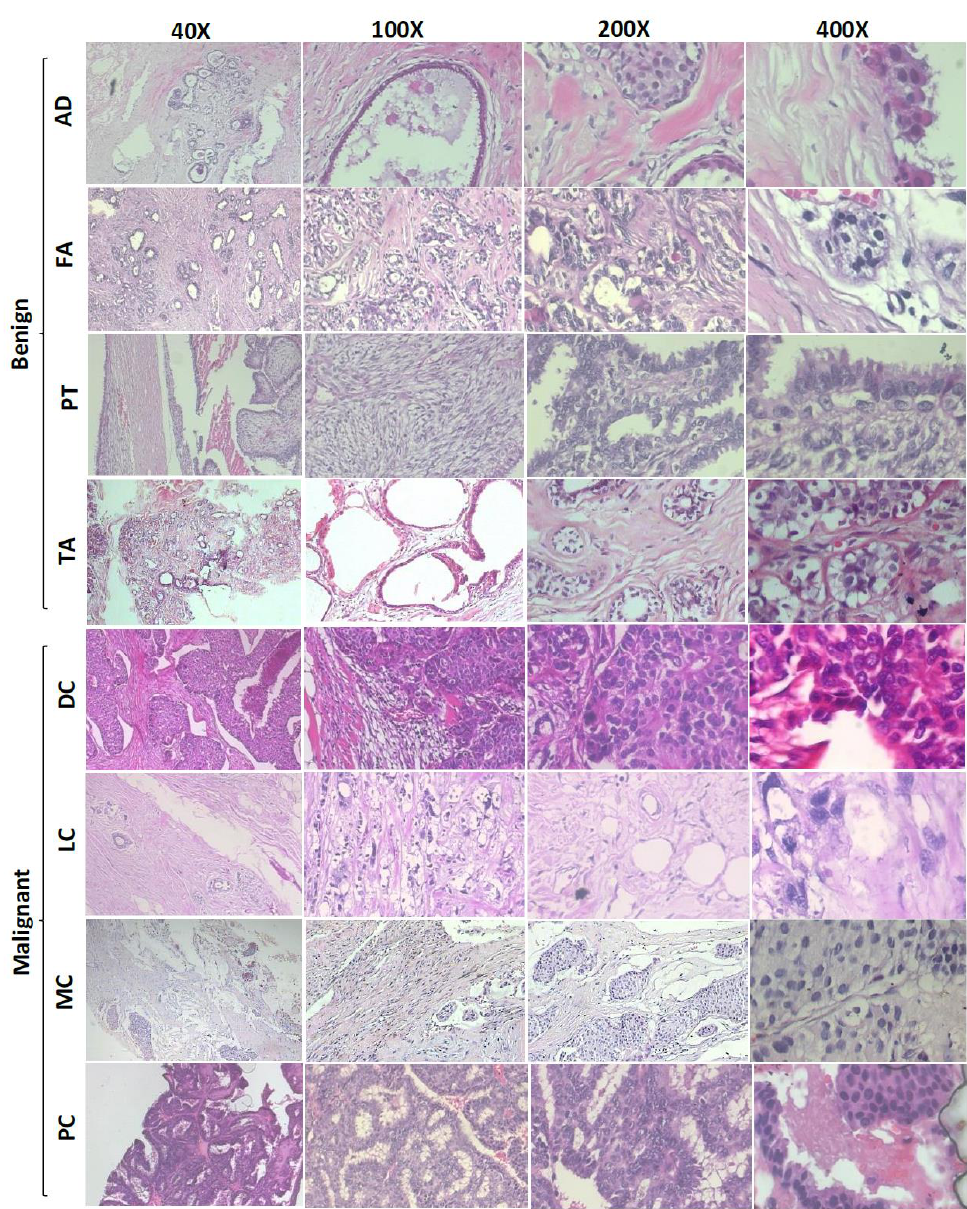
Figure 1. Sample images from the BreaKHis dataset shown at 40 × , 100 × , 200 × , and 400 × magnifica- tion factors. AD: adenosis, FA: fibroadenoma, PT: phyllodes tumor, TA: tubular adenoma, DC: ductal